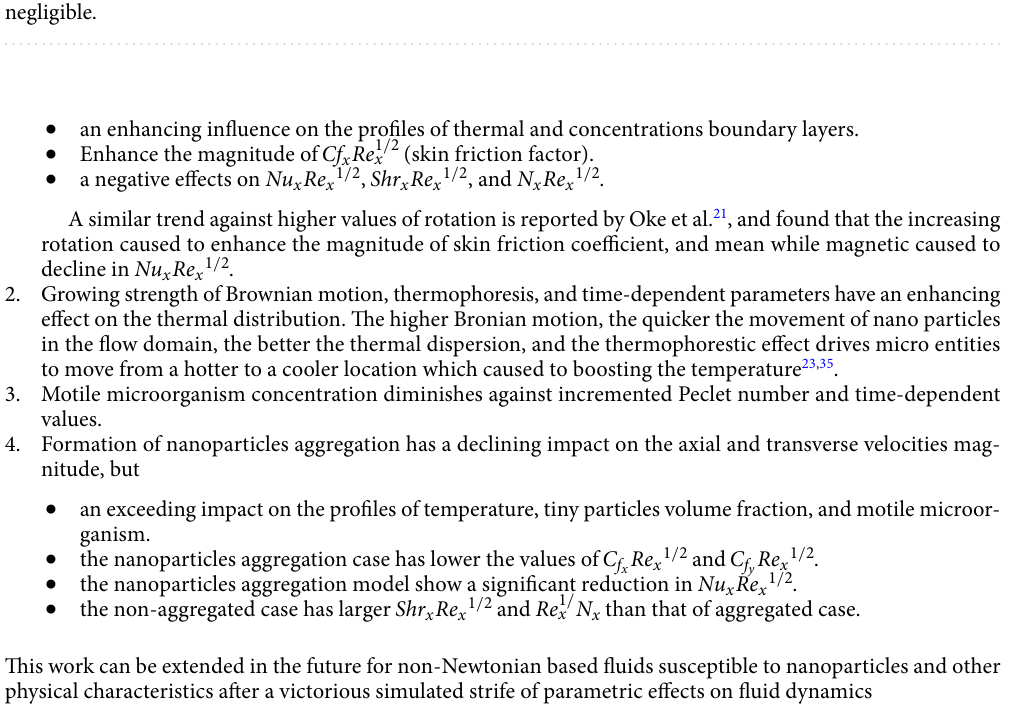
Table 5. Comparative of